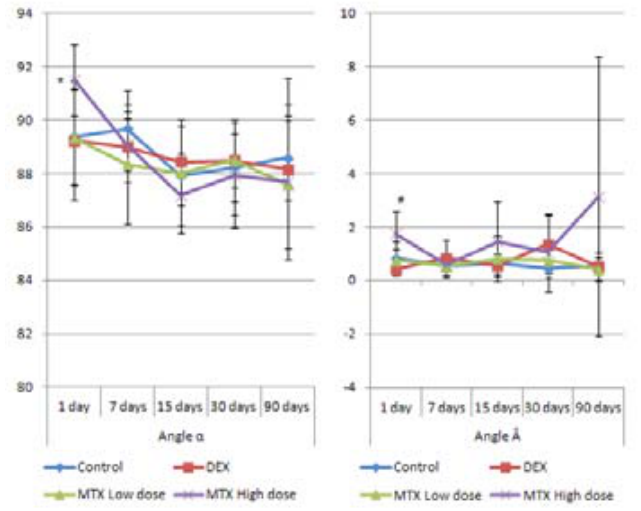
FIGURE 4 - Mean values and standard deviations (SD) of the cephalometric mensurations (degrees) of the angles α e Â of all the groups according to the experimental period. (*) Statistical difference between periods in MTX High dose group. ( # ) Statistical difference between